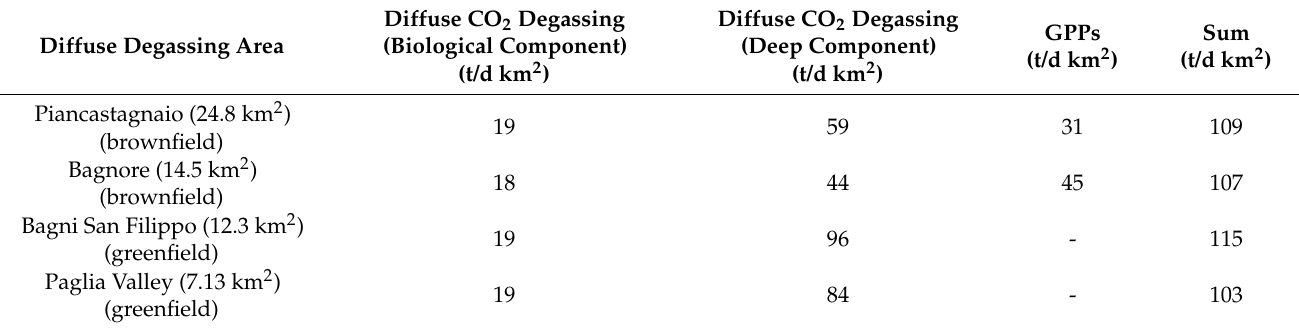
Table 8. Areal normalized natural and GPPs CO 2 fluxes, greenfields, and brownfields. GPPs calculated based on data from [13].